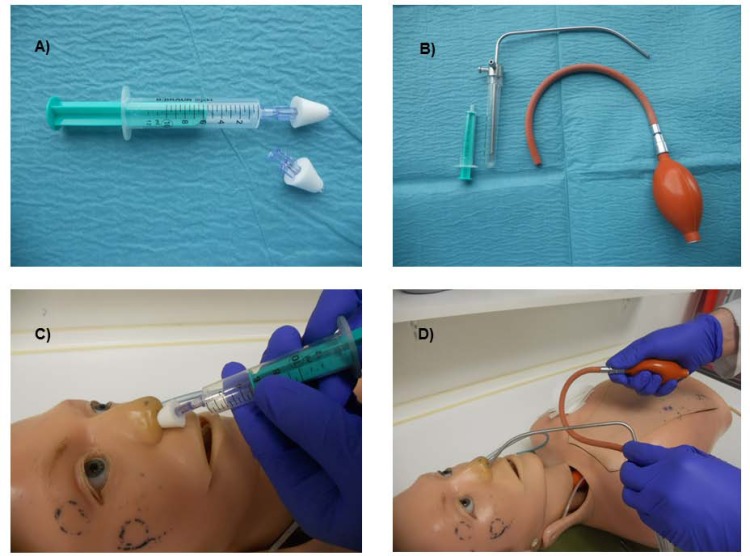
Atomizer Devices.